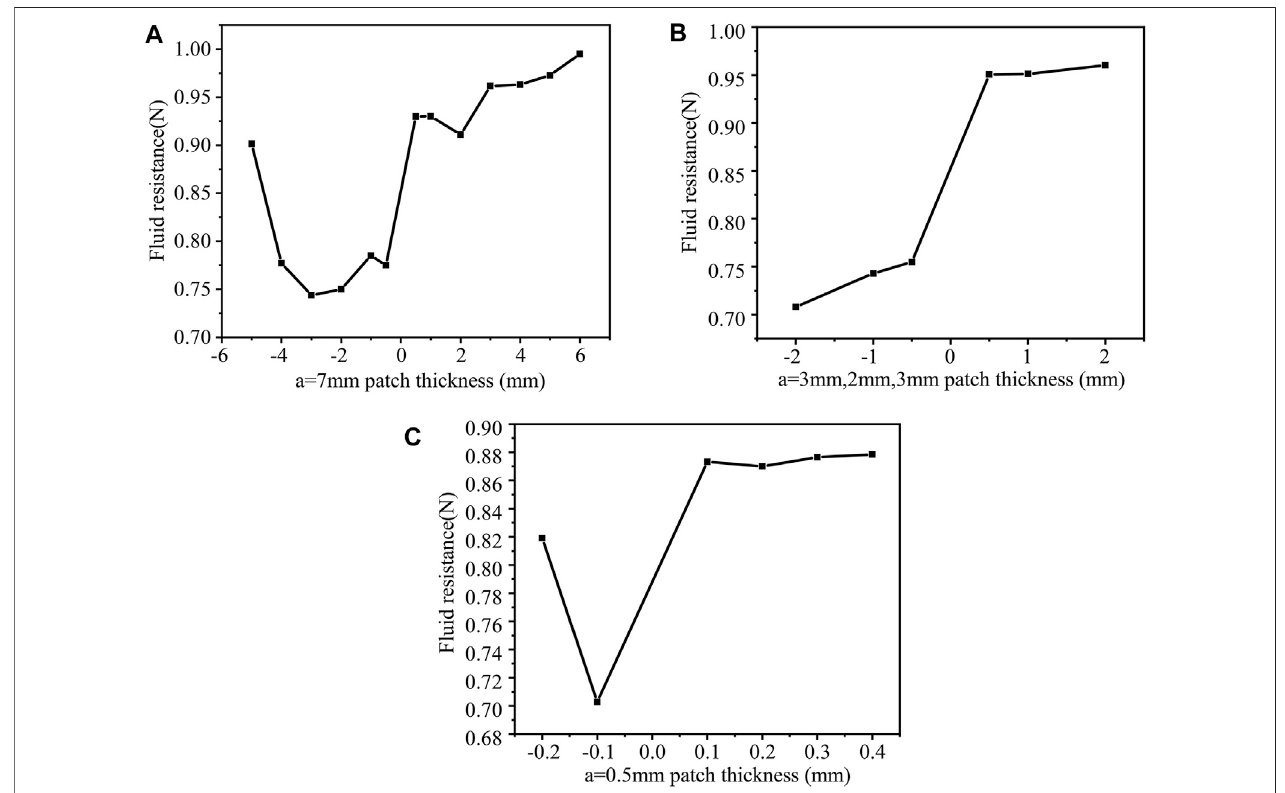
FIGURE 8 | The drag force under different patch numbers and different thickness patches (b = 6 mm). when (A) a = 7 mm; (B) a = 3mm, 2 mm, 3 mm; (C) a = 0.5 mm.